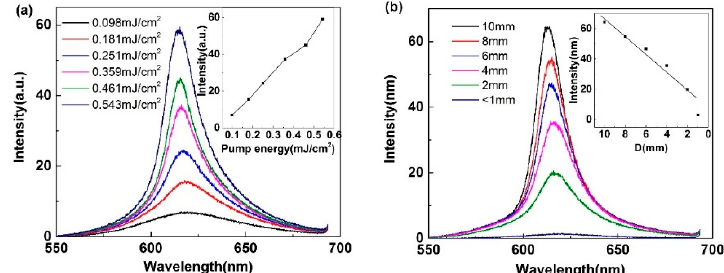
Figure 7. The emission spectrum of the NPDDNLC sample when the pump area is a circle spot. ( a ) The emission spectrum of the NPDDNLC sample at different pump energy densities, when the diameter (D) of pump area is 10 mm. Inset shows the peak intensity of the corresponding emission spectrum as a function of the pump energy density. ( b ) The emission spectrum of the NPDDNLC sample as a function of the diameter of pump area, when the pump energy density is 0.57 mJ/cm 2 . Inset shows the peak intensity of the corresponding emission spectrum as a function of the diameter of pump area.